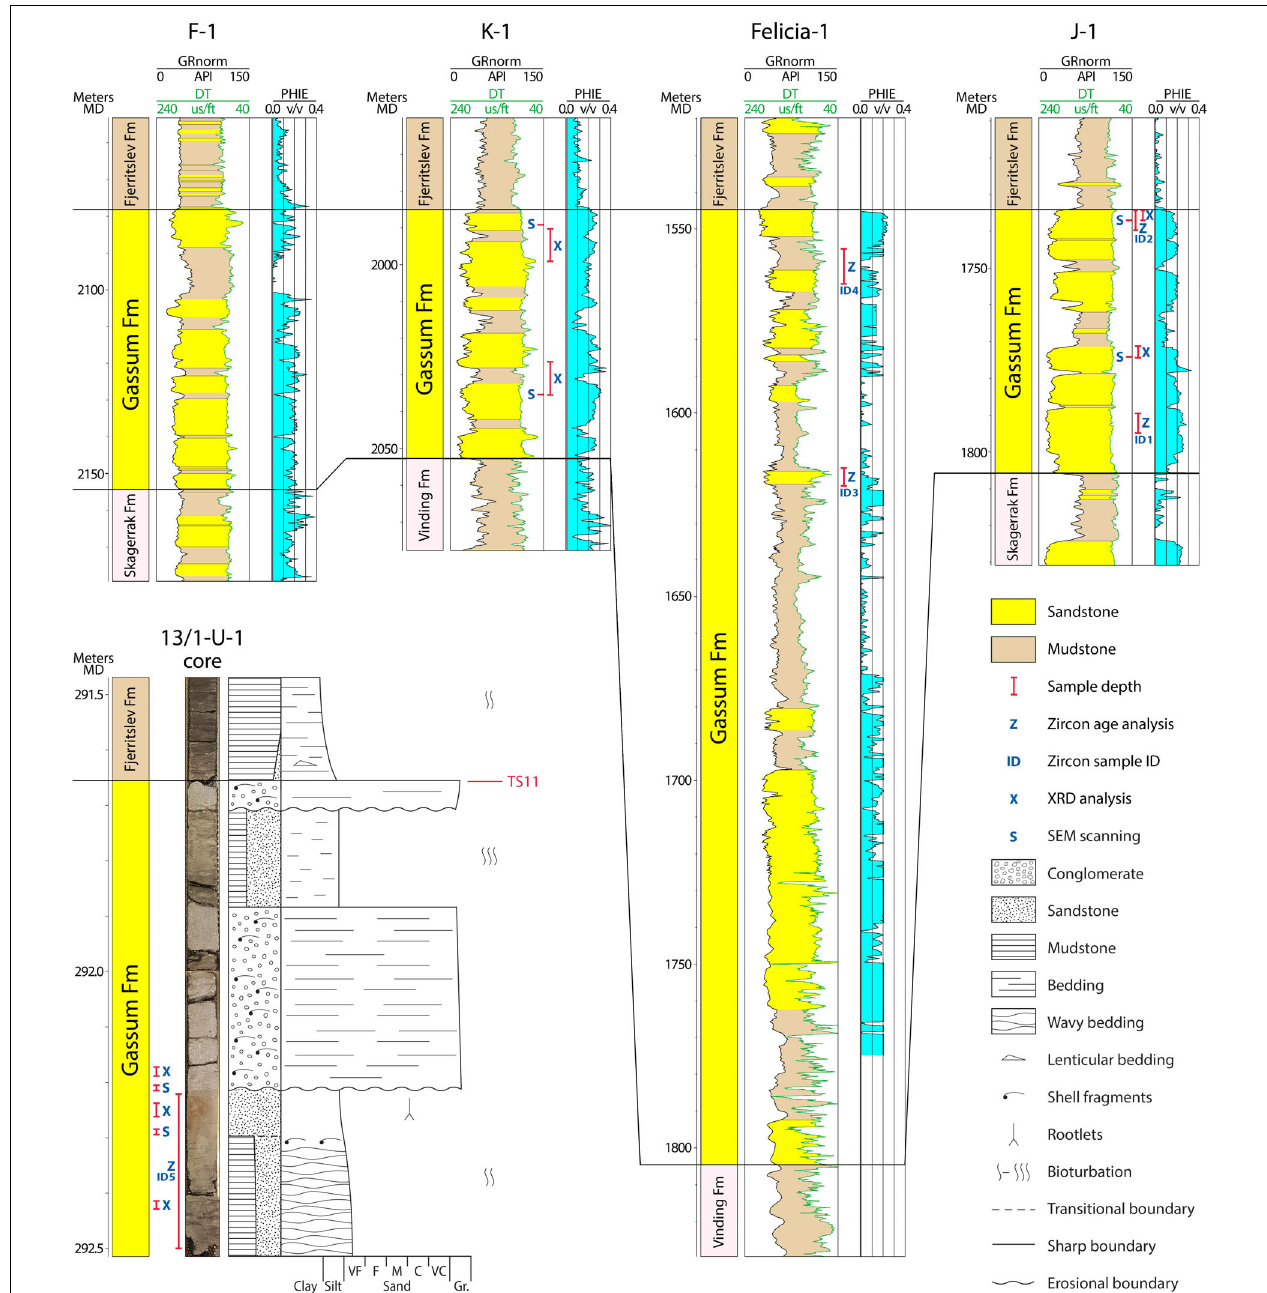
FIGURE 4 | Lithological columns of well-sections of the Gassum Formation with wireline logs and indicated sample depths. The lithostratigraphy is based on Nielsen and Japsen (1991). A sedimentological log of the cored section from the 13/1-U-1 well is shown alongside the core photos. Locations are shown in Figure 1 . TS11 is a transgressive